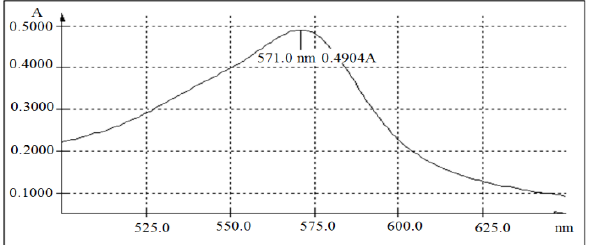
Fig. 4. Absorption spectrum of the solution of fructose P (3.3·10 -6 μg) with α-naphthol in acidic medium with urea additives (3 mg/ml and boric acid 6 mg/ml)